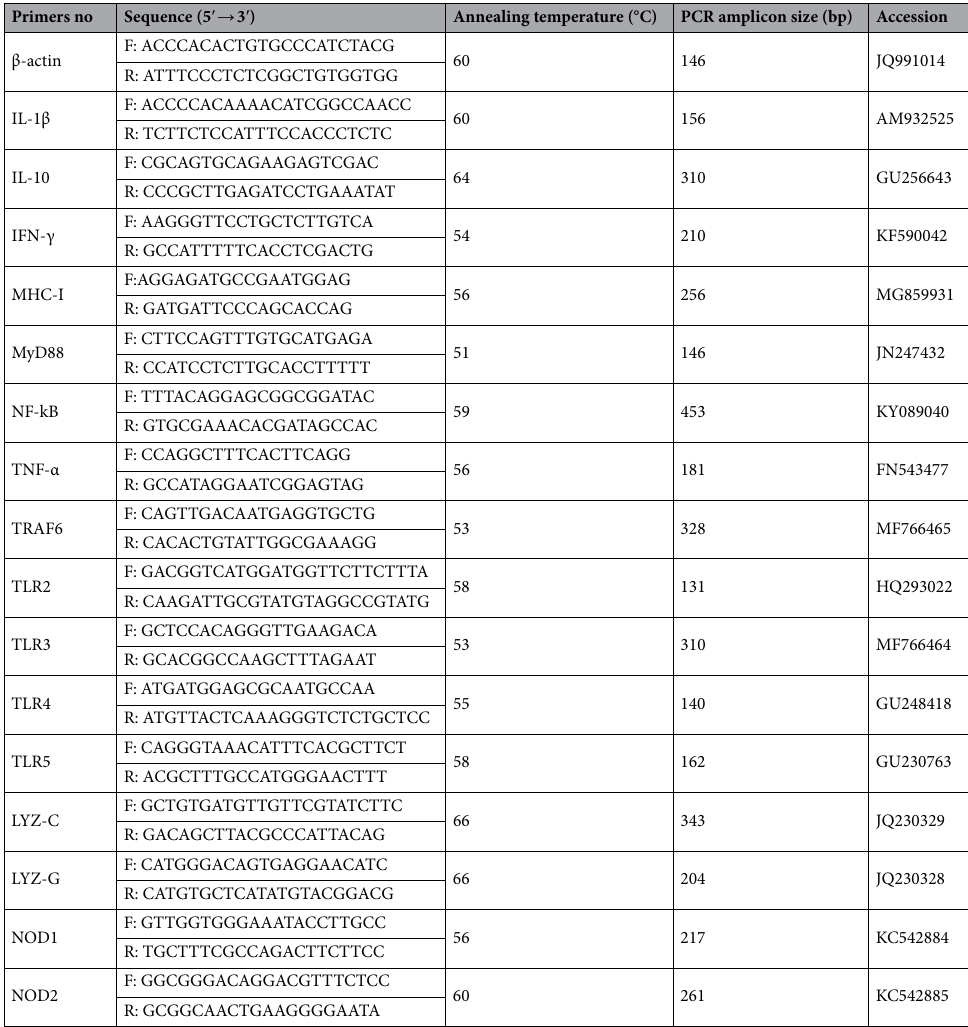
Table 2. List of gene primers used for tissue specific expression pattern of selected immune related genes in C. catla . IL‑1β/10 interleukins1β/10, IFN‑γ interferon-gamma, TNF‑α tumor necrosis factor-alpha, TRAF6 TNF receptor-associated factor 6, TLR2/3/4/5 toll-like receptors 2/3/4/5, LYZ‑C/G lysozyme-C/G, NOD1/2 nucleotide binding oligomerization domain containing 1/2, NF‑kB nuclear factor kappa-light-chain-enhancer of activated B cells, MyD88 myeloid differentiation primary response 88, MHC‑I major histocompatibility complex-class